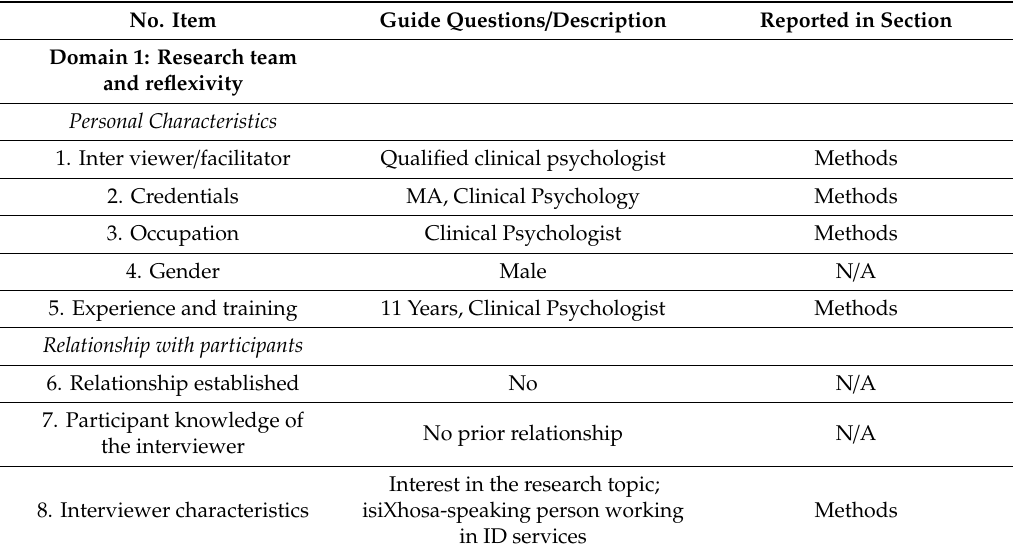
Table A1. Consolidated criteria for reporting qualitative studies (COREQ): 32-item